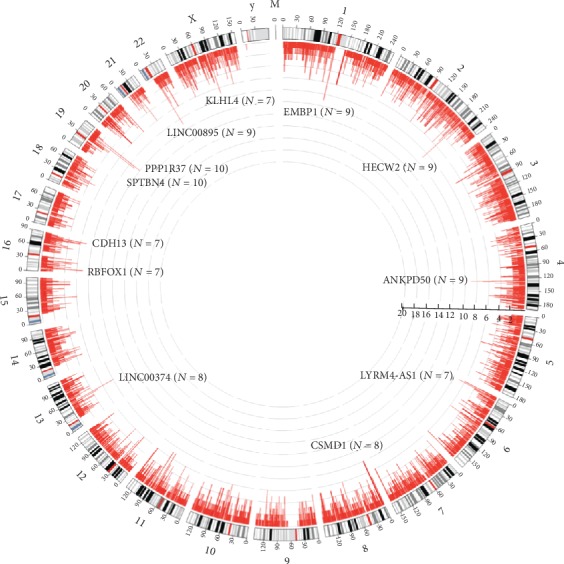
Distribution of breakpoints in the human genomes in 40 samples. Note: in the outer circle, each bar denotes the location of HPV integration into the 24 human chromosomes and the mitochondrial genome. Histogram axis units represent the number of samples, and outer DNA numbering is given in millions of bases. In the inner circle, each red bar depicts the frequency of HPV integration.